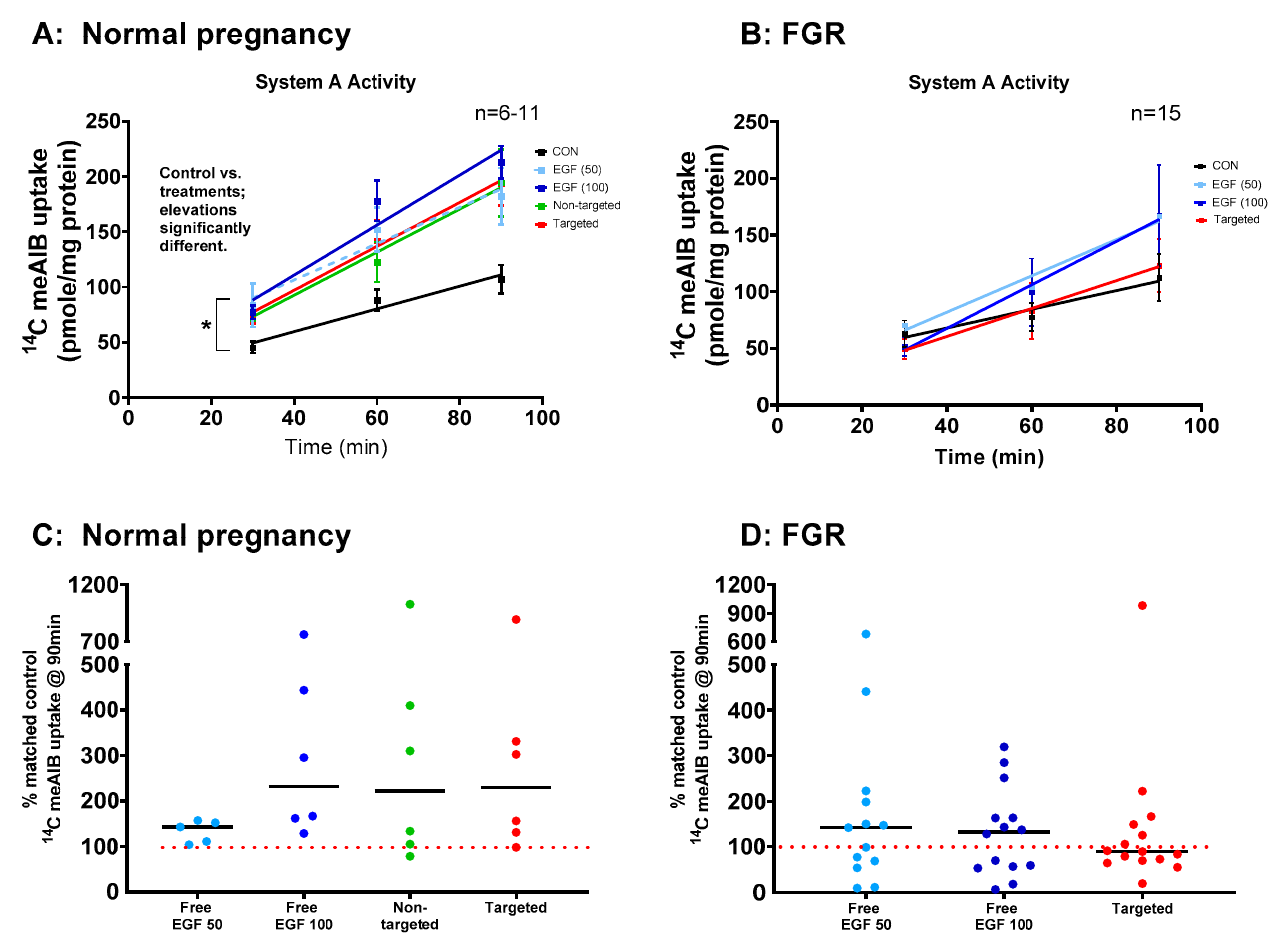
Figure 5. Targeted delivery of EGF increases System A amino acid transport activity in human placental explants. Third- trimester explants from healthy ( A ) and FGR ( B ) pregnancies were cultured for 7 days and treated with either 10 µL PBS (control), free EGF (50 or 100 ng/mL), undecorated liposomes encapsulating 50 ng/mL EGF (non-targeted) or GPS-decorated liposomes, encapsulating 50 ng/mL EGF (targeted) for 48 h on days 5–7. Na + -dependent uptake of 14 C MeAIB ( A , B ) (System A activity) measured at 30, 60 and 90 min. Mean ± SEM. n = 6–15 placentas. Asterisk donates the linear regression elevations are significantly different ( p < 0.05) in ( A ) with individual post hoc analyses; control vs. EGF 50 ng/mL p = 0.02, control vs. EGF 100 ng/mL p < 0.0001, control vs. non-targeted p = 0.04, control vs. targeted p = 0.03. ( C , D ) Percentage of Na + -dependent uptake of 14 C MeAIB compared to levels in matched control explants at 90 min. Median, n = 6–15 placentas. EGF = epidermal growth factor, FGR = fetal growth restriction, MeAIB = 2-Methylaminoisobutyric acid.